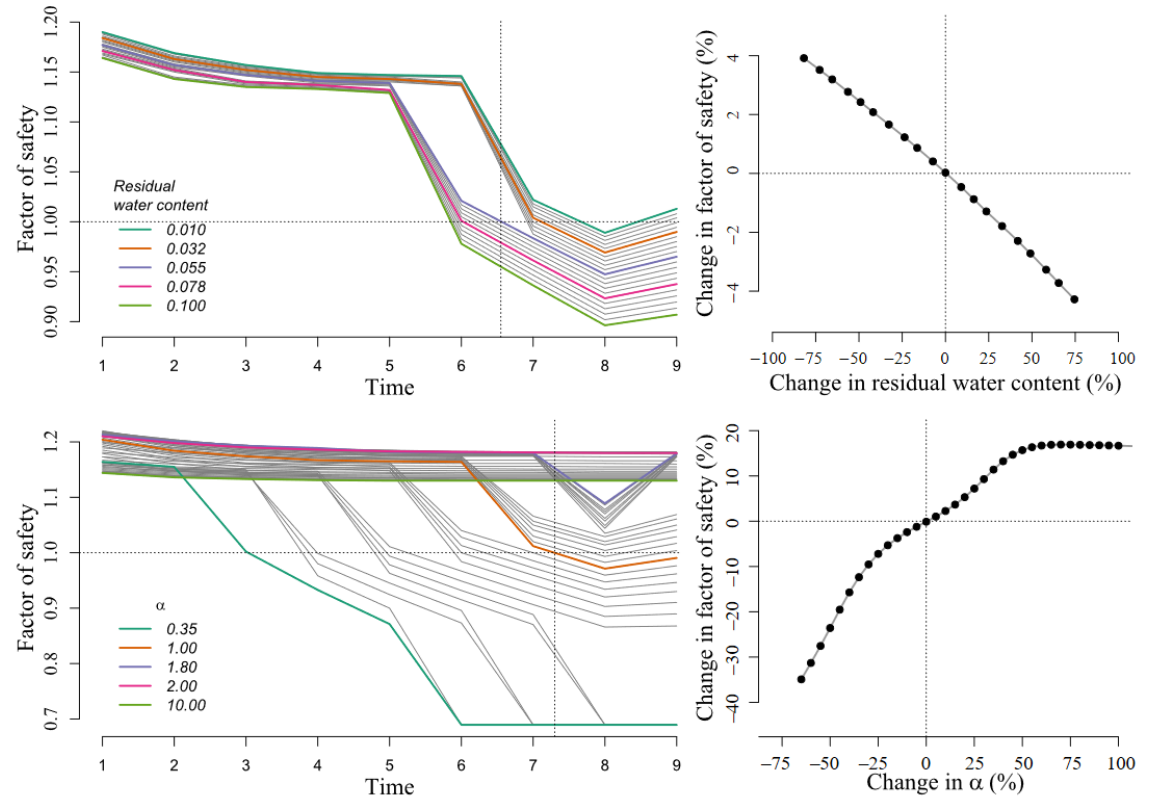
Figure 16. Sensitivity analysis of SHPs, residual water content ( θ r ), and a fitting parameter for